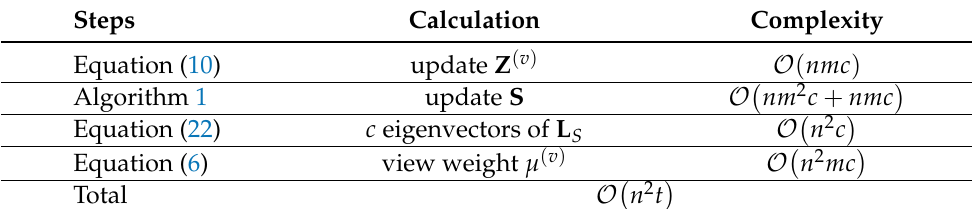
Table 1. Details of computational